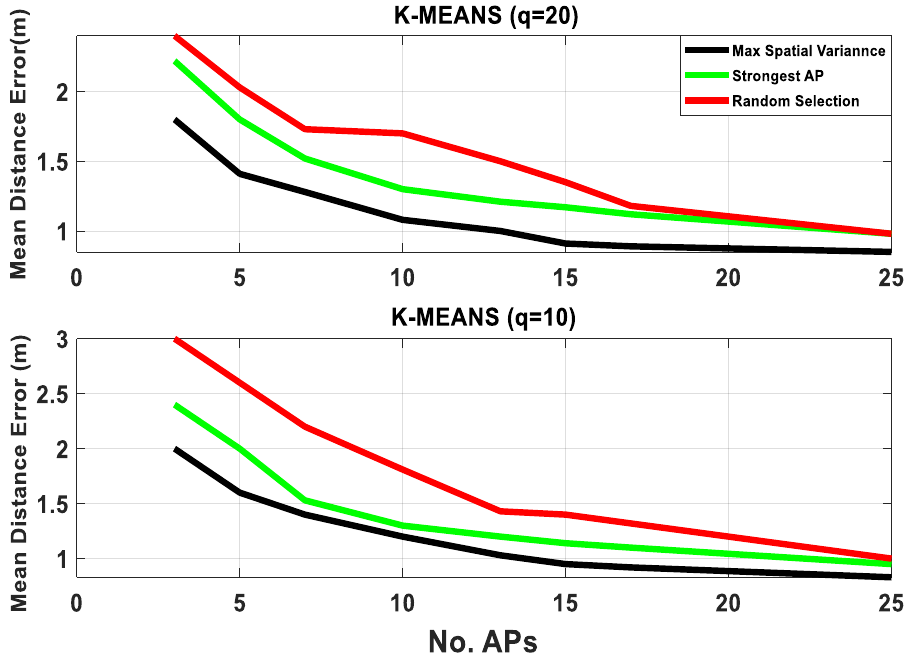
Figure 13. K-means-based proposed system with different values of clusters.